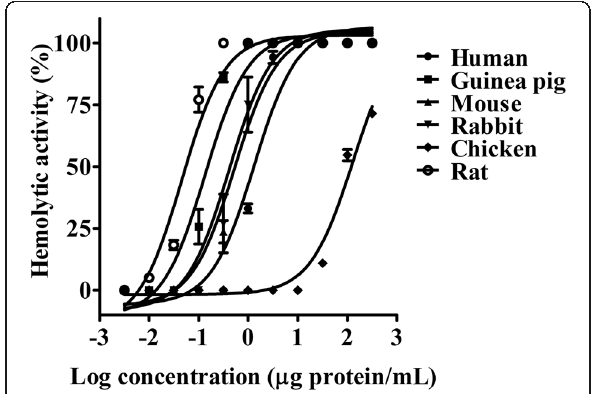
Fig. 1 Concentration-response curves showing the hemolytic activity of the M. alcicornis aqueous extract on erythrocytes from various species